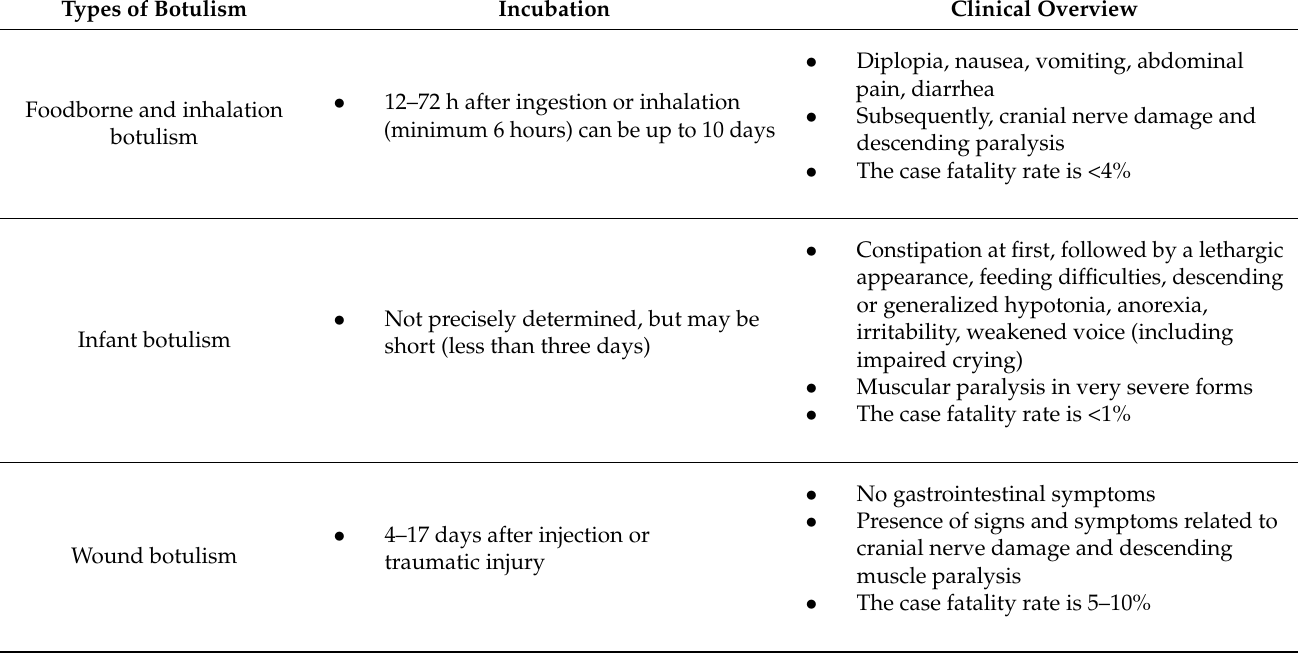
Table 2. Incubation time and clinical overview of the main types of human botulisms *.